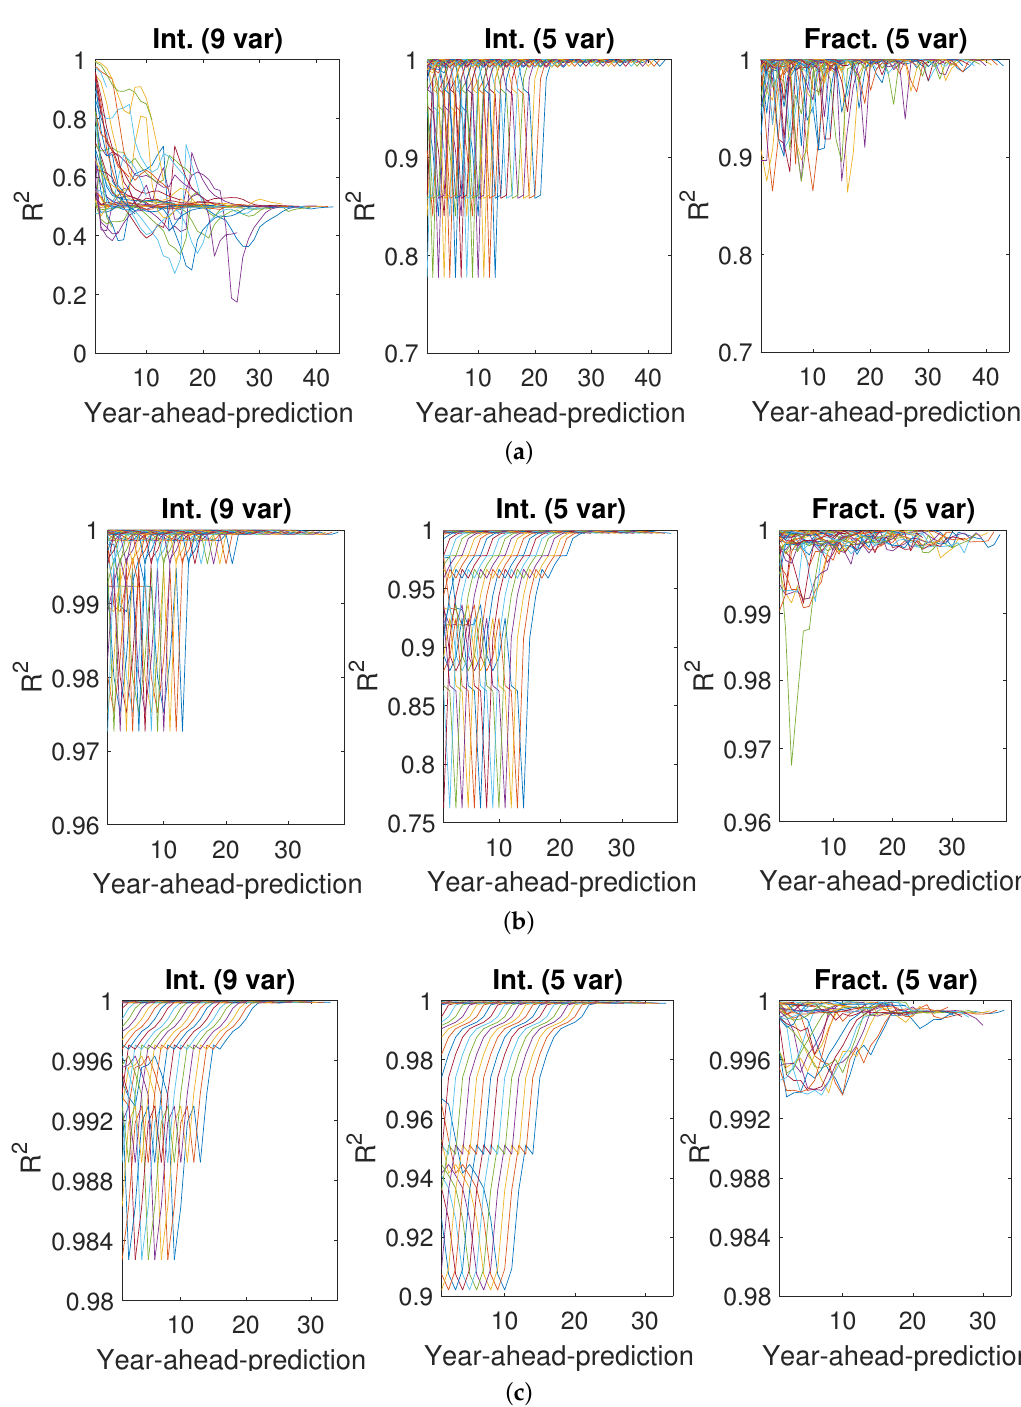
Figure 8. R 2 values of GDP estimates for South Africa. Estimates were obtained with models (1) (left), (2) (middle), and (3) (right). The models were obtained with data for different numbers of years: ( a ) N = 5 (top) ( b ) N = 10 (center) ( c ) N = 15 (bottom). The models were used to estimate the GDP for as many years as possible after the period for which they were built. The scale of the y -axis is not the same for all models and all values of N